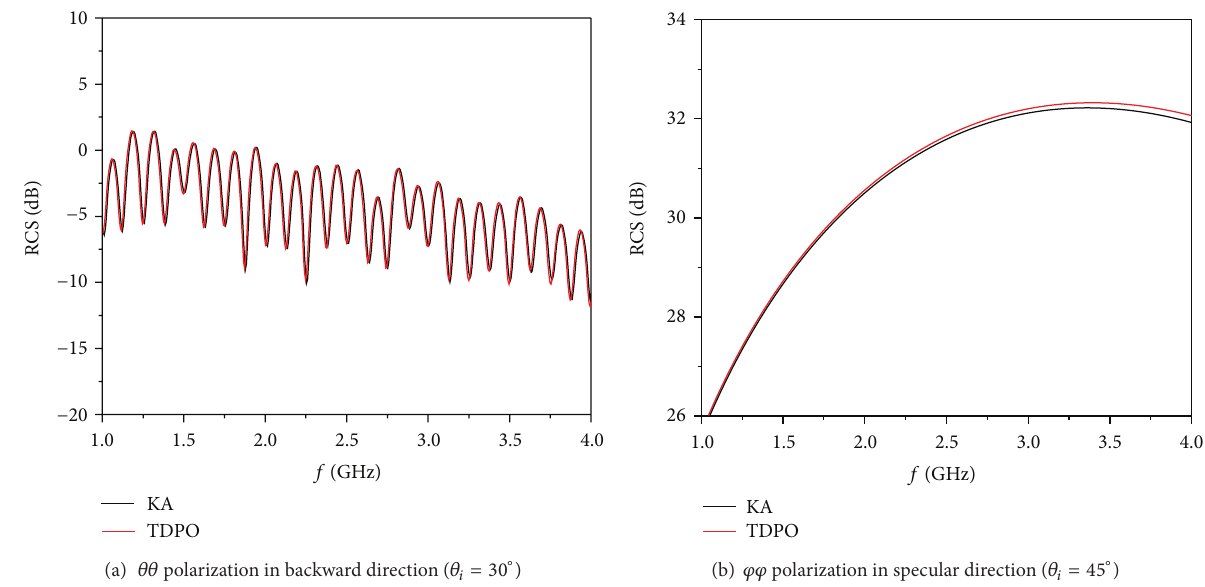
Figure 3: TDPO and KA methods for the wide-band RCS from 2D PEC rough